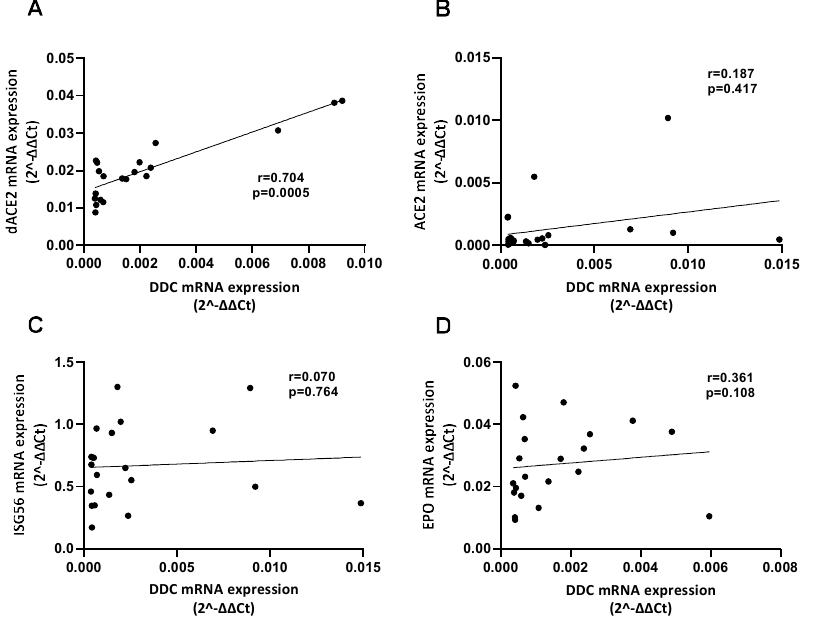
Figure 3. Correlation of the expression of dACE2 ( A ), ACE2 ( B ), ISG56 ( C ) and EPO ( D ) with DDC in the nasopharyngeal swab samples of COVID-19 patients with severe symptoms (Severe CoV-2) . Data are presented as XY scatter plots with fitted linear regression lines. Pearson’s or Spearman’s correlation coefficient (r) and p -values (p) were calculated.